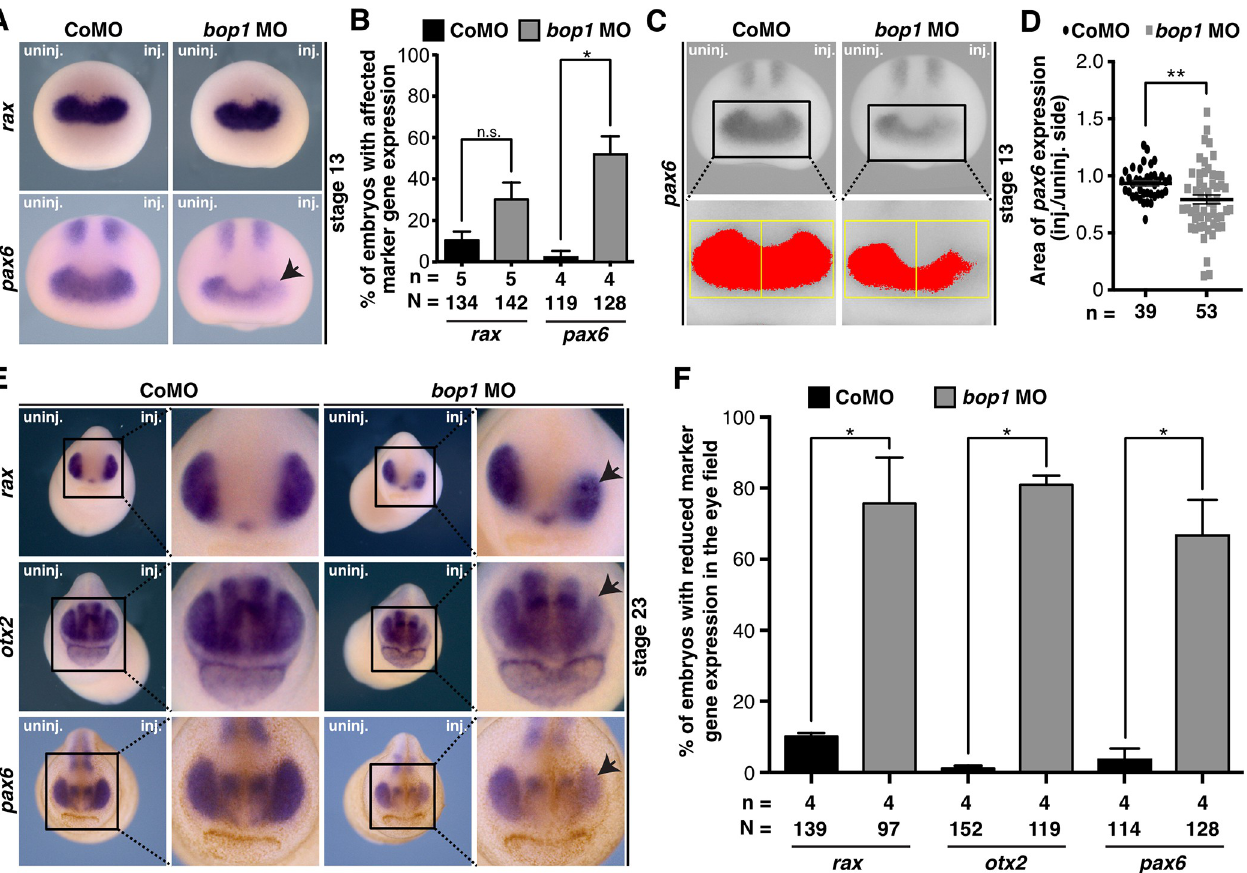
Fig 6. Eye-specific marker genes upon Bop1 deficiency. A Xenopus laevis embryos at stage 13 injected with 20 ng bop1 MO or Control MO and analyzed by whole mount in situ hybridization. rax and pax6 served as eye-specific marker genes (black arrow indicates location of altered gene expression). Anterior view of embryos is given. B Quantitative representation of data given in A. C pax6 expression was analyzed in stage 13 bop1 morphants (anterior view is shown). Expression domain was photographed and area was measured via ImageJ. Injected side was compared to uninjected side. Yellow boxes indicate area where pax6 expression (red colored area) was measured. D pax6 expression is significantly reduced on the injected side of bop1 MO-injected embryos. E Stage 23 embryos injected with 20 ng bop1 MO or Control MO. Anterior view is given. rax , otx2 , and pax6 were used as eye-specific marker genes (black arrows indicate the location of the altered gene expression). F The expression of all three marker genes was significantly reduced in bop1 morphants. Abbreviations: bop1 MO, block of proliferation 1 morpholino oligonucleotide; CoMO, Control MO; inj., injected side; n, number of independent experiments; N, number of injected and analyzed embryos; n.s., non-significant; uninj., uninjected side. Error bars indicate standard error of the means; � , p � 0.05; �� , p �